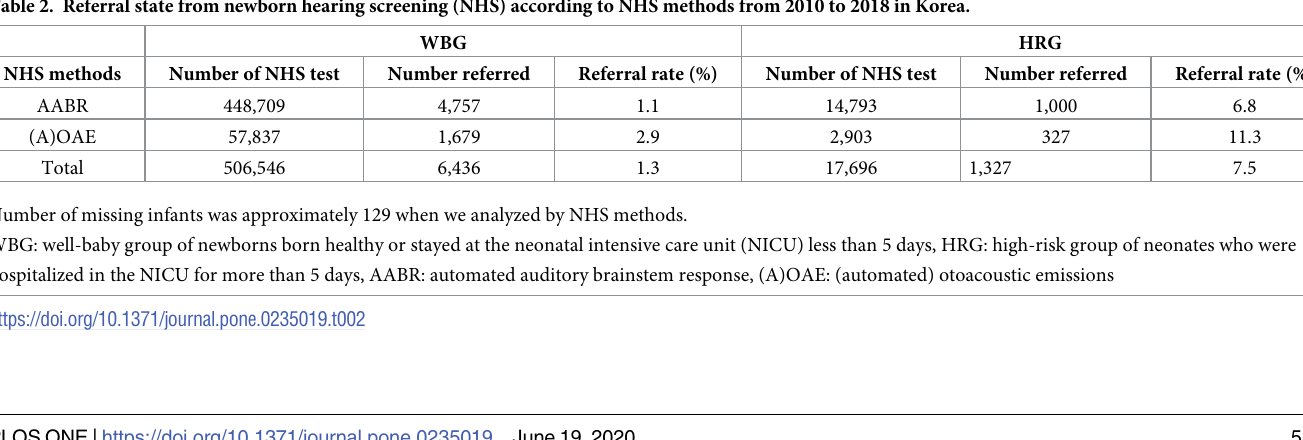
Table 2. Referral state from newborn hearing screening (NHS) according to NHS methods from 2010 to 2018 in Korea. WBG HRG